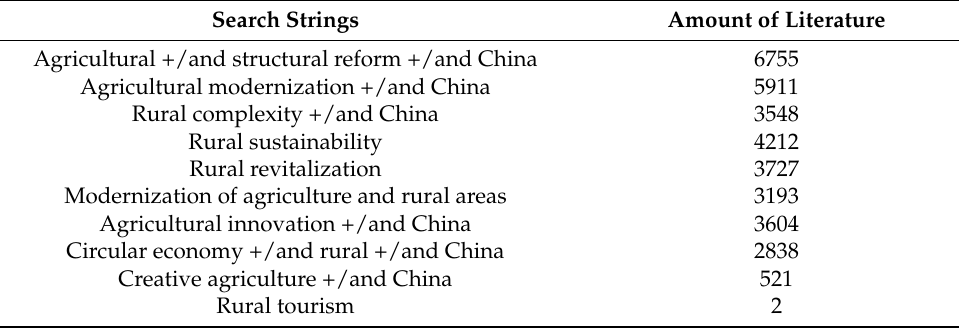
Table 1. The search result on supply–demand structural reform from 2011–2021. Search Strings Amount of Literature Agricultural +/and structural reform +/and China